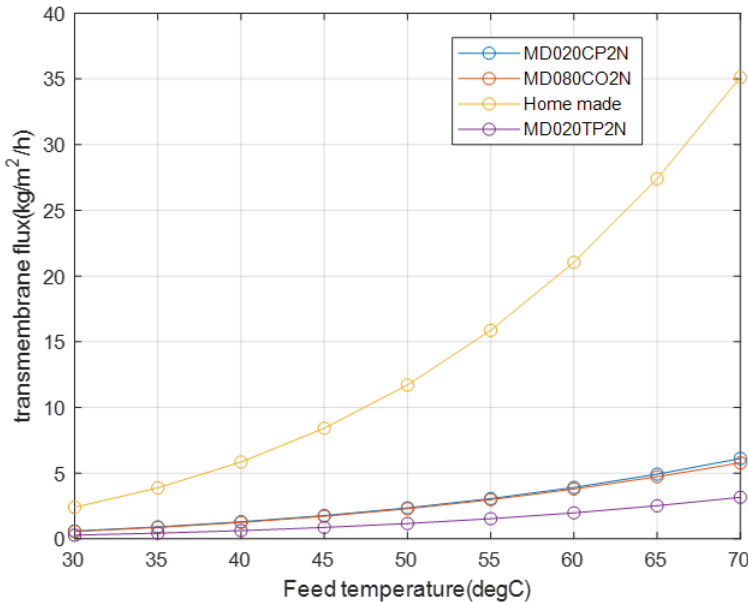
Figure 6. Transmembrane flux with respect to the feed temperature.